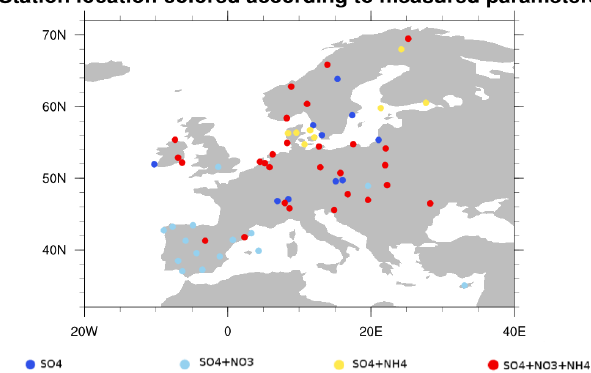
Figure 2. Map with the locations of the stations measuring SIA composition on a daily basis, from the EMEP database used to eval- uate the regional model results. Colours represent the measured pa- rameters at the station. The domain plotted corresponds to the limit of the regional domain of the simulation. Colours represent the alti- tude of the